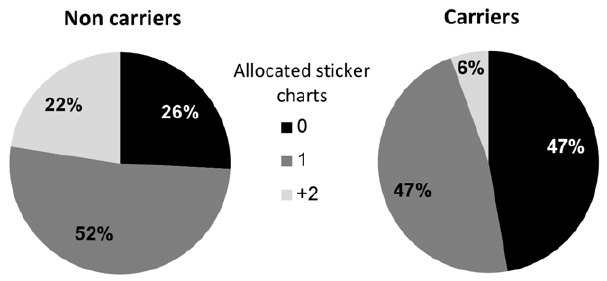
Figure 1. The effect of AVPR1A RS3 ‘target allele’ on allocations in the DG. Percentage of children according to the number of sticker charts allocated in the DG (0, 1 or 2 and more), and the presence/absence of the ‘target allele’. Compared with non carriers, carriers are much less likely to allocate more than 2 sticker charts, and more likely to allocate nothing. ‘target allele’ vs. all others, and sticker chart allocations, x 2 (1, N = 136)= 3.89, p = 0.04, indicating carriers as less likely to